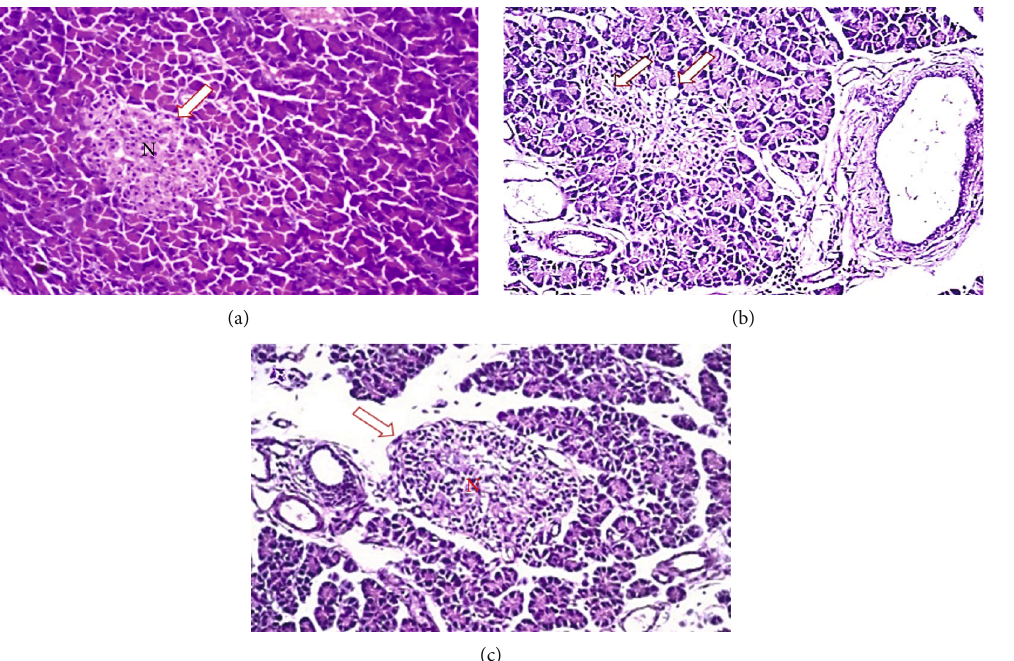
Figure 4: E ff ect of MAE of C. myrrha on pancreatic Langerhans islet cells after 30 days in albino rats: (a) histological appearance of Langerhans islets of normal control rats (NCG) showing no histopathological changes, (b) histological appearance of Langerhans islets of STZ-induced diabetic rats (DG) showing degenerative changes and atrophy associated with dilatation of the exocrine ducts (see arrow), and (c) histological appearance of Langerhans islets of the treated group (MAETG) showing the normal histopathological